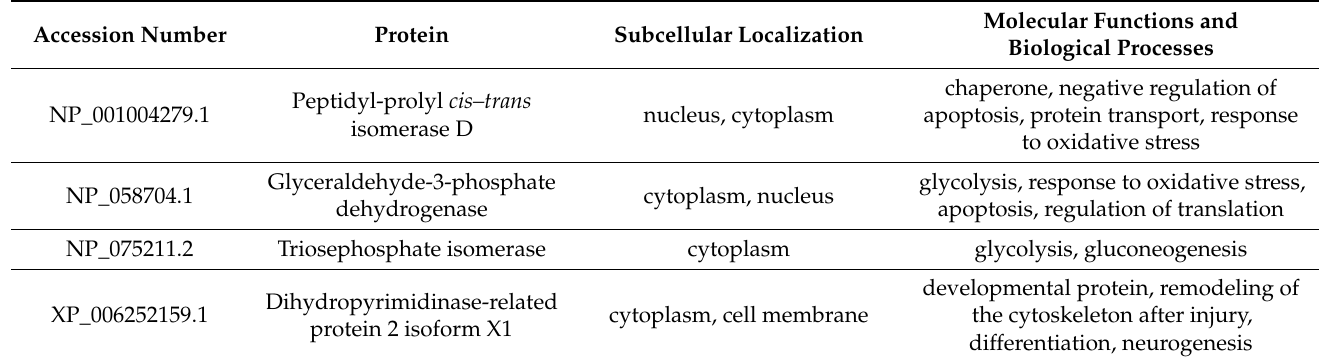
Table 4. Subcellular localization and function of altered proteins in mPFC isolated from SNL versus sham-operated rats 8 weeks after the